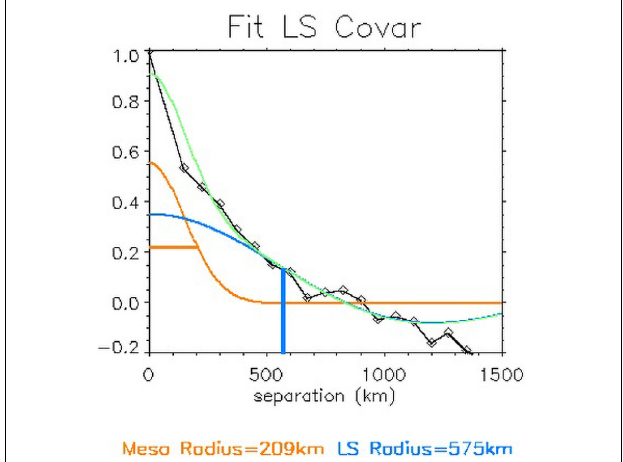
FIGURE 11 | The covariance as a function of the separation distance is shown in black. The Gaussian in orange is the closest approximation to the mesoscale error; the cardinal sine in blue is the approximation to the large-scale error; the covariance approximation (the sum MS+LS) is in